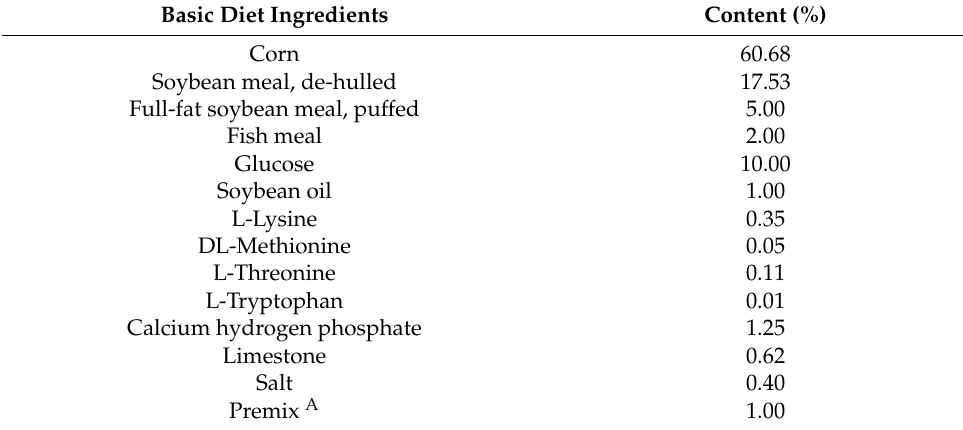
Table 2. Composition of glucose-supplemented diets (90% of dry